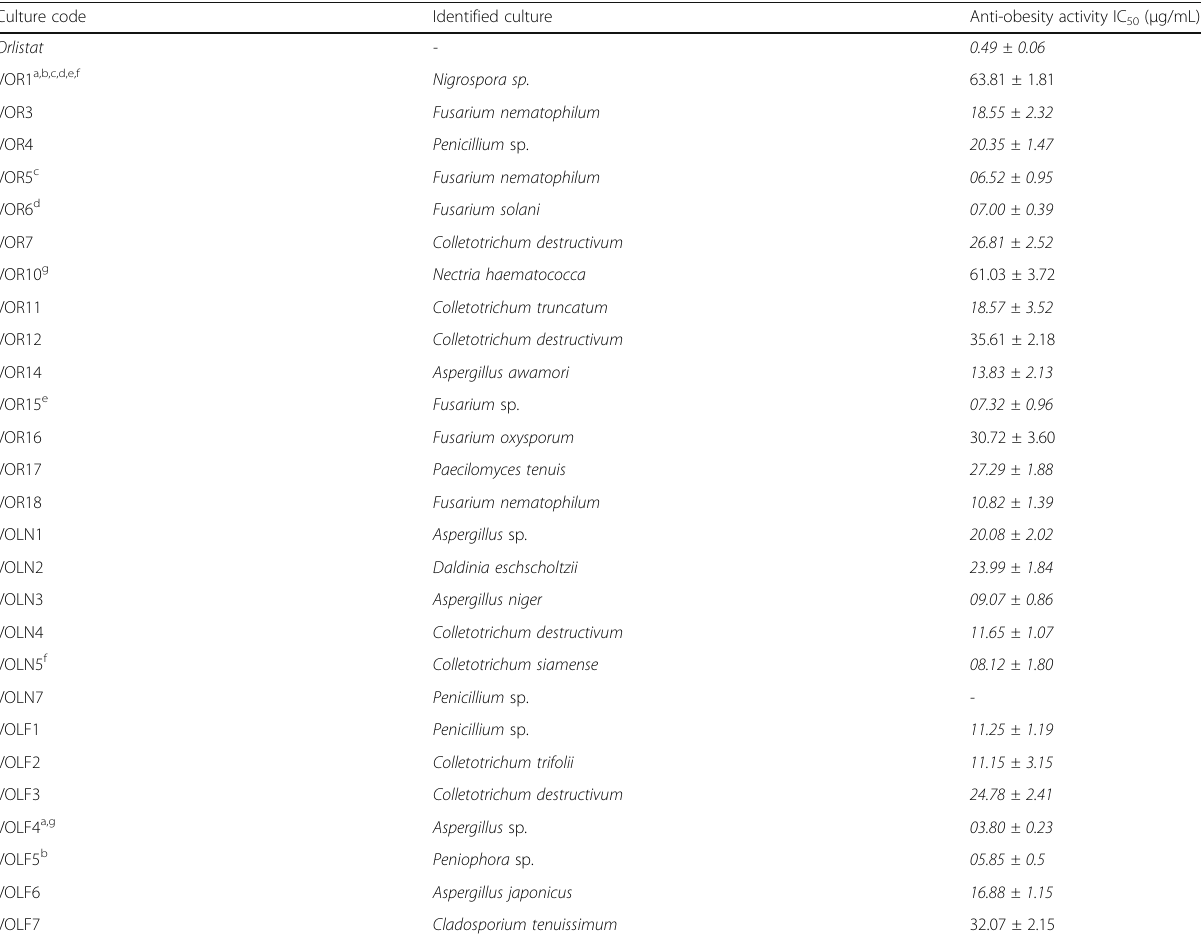
Table 2 Anti-obesity activity (IC 50 μ g/mL) of endophytic fungi isolated from V. odorata Culture